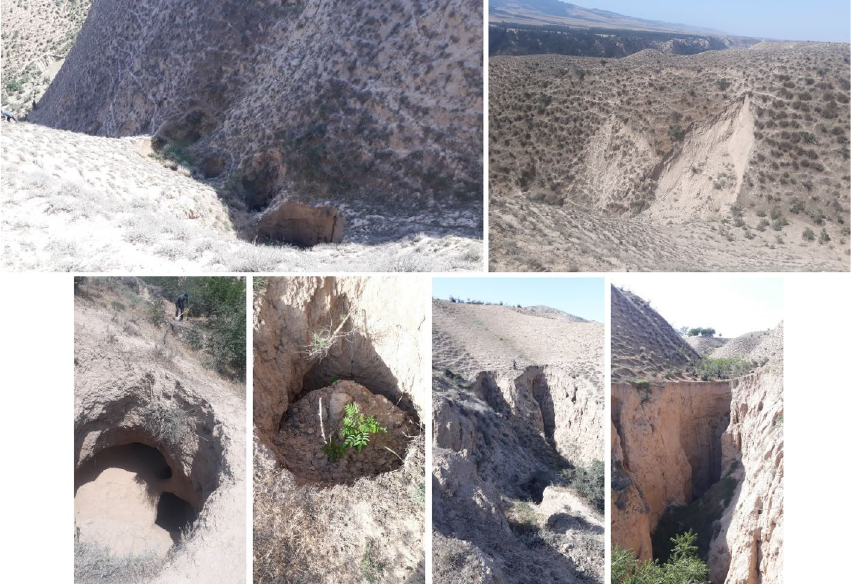
Figure 8. Some examples of three soil landforms (collapsed pipes, gully heads, and landslides) in the study area.